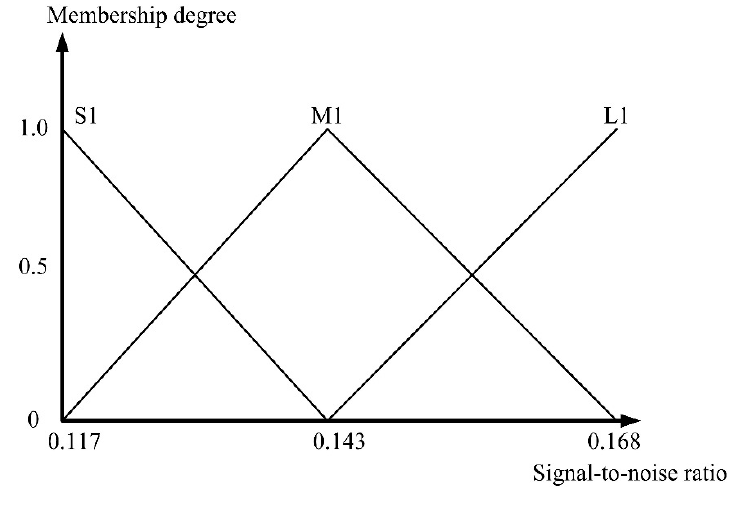
Figure 6. Cont. Figure 6. Cont